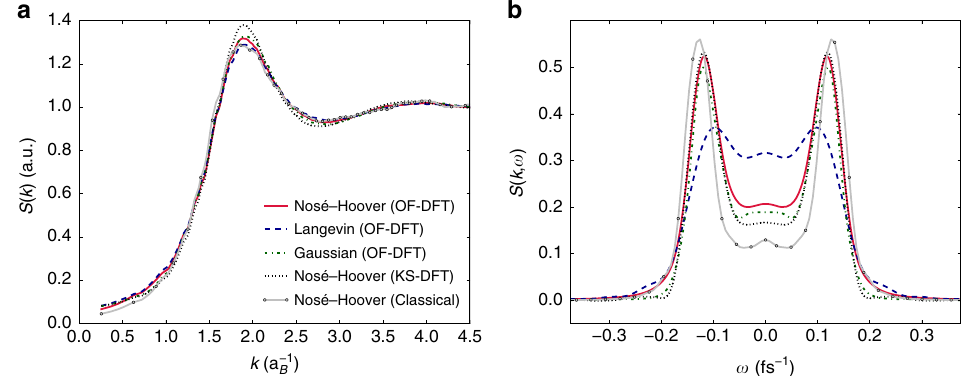
Figure 1 | Static and dynamic structure factors of warm dense aluminium. ( a ) The ion–ion static structure factor. ( b ) The ion–ion dynamic structure . The structure factors ( T e ¼ T i ¼ 3.5eV and r ¼ 5.2gcm (cid:2) 3 ), are calculated from orbital-free density functional theory (OF-DFT) factor at k ¼ 0.51 a (cid:2) 1 B simulations in a canonical ensemble with a Nose´–Hoover, Langevin and Gaussian thermostat; The Langevin thermostat uses a collision induced friction, s , of 6 (cid:5) 10 13 s (cid:2) 1 . For comparison, results from a Kohn–Sham density functional theory (KS-DFT) simulation and a fully classical simulation using a screened Coulomb potential with an added short-range repulsion, both in a canonical ensemble with a Nose´–Hoover thermostat (dotted) are also